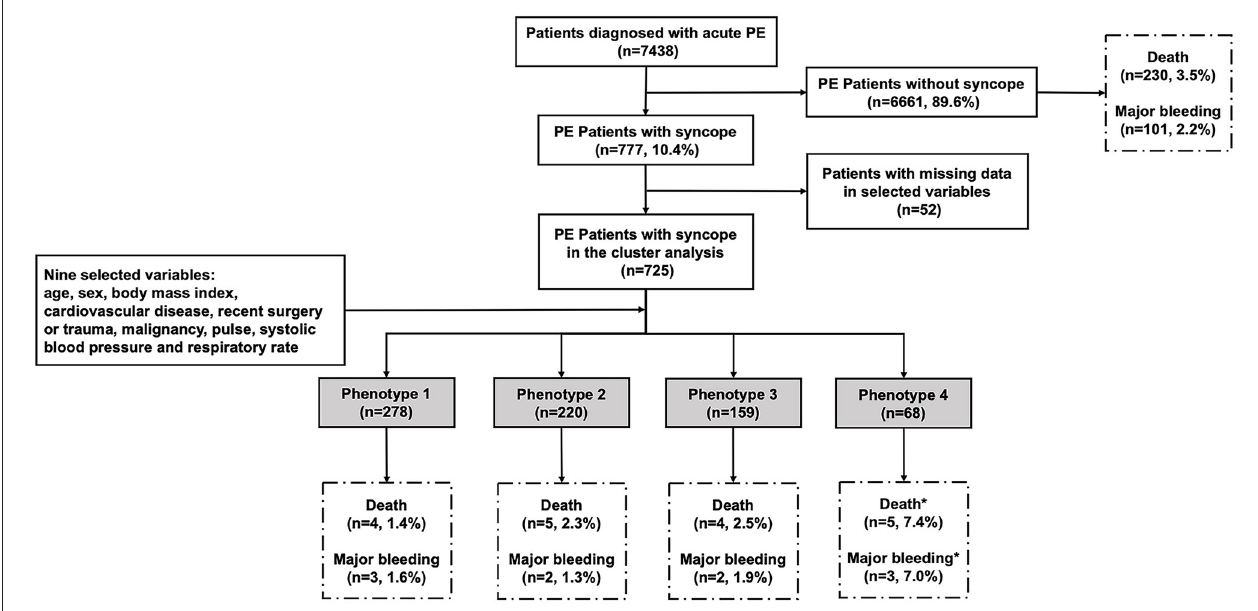
FIGURE 1 | The flowchart of the study. We enrolled 7,438 patients confirmed with acute PE, in which 777 patients had syncope as one of initial symptoms. Nine variables were selected for their relevance to syncope and PE: age, sex, body mass index, cardiovascular disease, recent surgery or trauma, malignancy, pulse, systolic blood pressure, and respiratory rate. Complete data for the nine variables were available for 725 subjects with syncope. In the system cluster analysis, they were classified into four phenotypes, with different outcomes during admission. * The difference is statistically significant compared with other